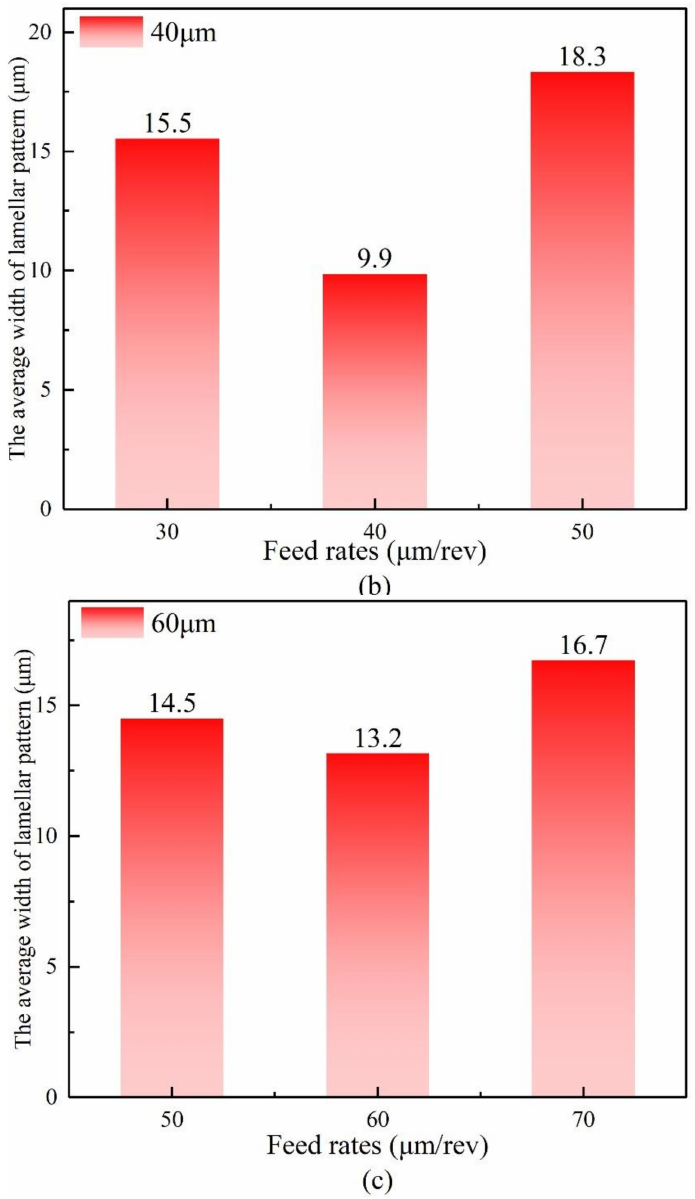
Figure 8. The average width of the lamellar structure: ( a ) 30 µ m, ( b ) 40 µ m, ( c ) 60 µ m.